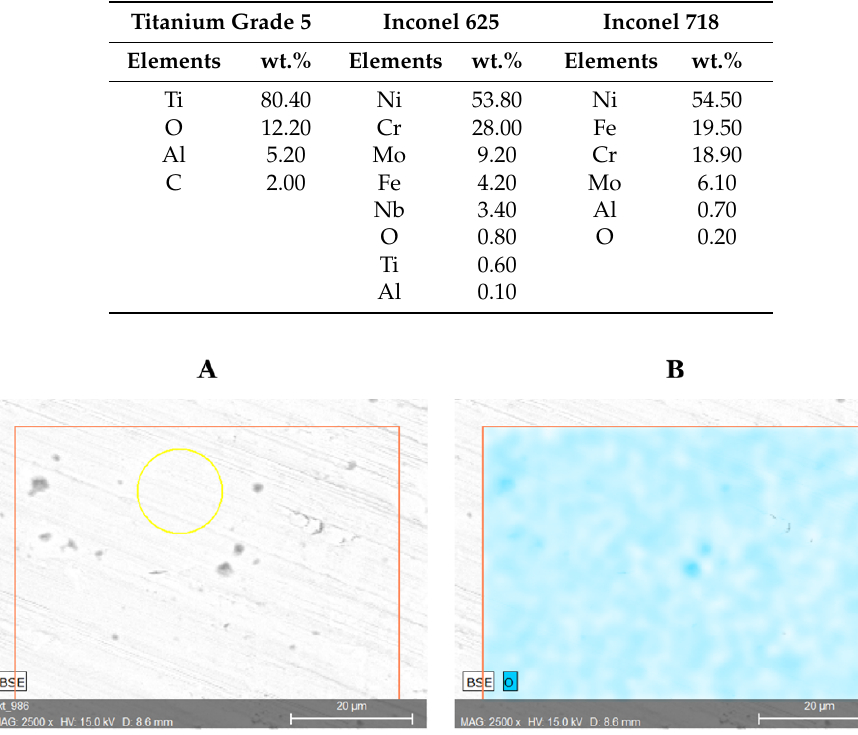
Table 4. The SEM-EDS elemental results of alloy swarfs surface analyses.